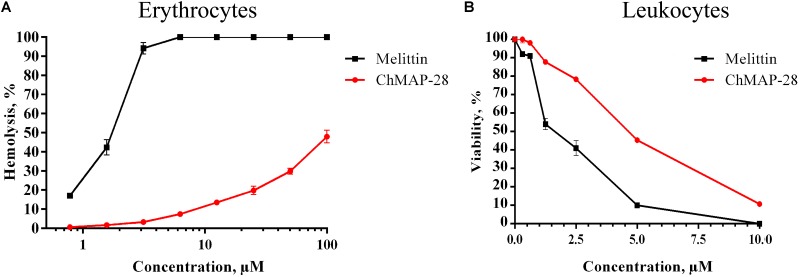
Toxicity of ChMAP-28 and melittin to normal human blood cells. (A) Concentration-dependent curve of ChMAP-28 and melittin toward PBMC assessed by MTT-test. (B) The hemolysis curve showing effects of ChMAP-28 and mellitin on human erythrocytes. The data represent the mean values ± SD of three independent series of triplicated experiments.